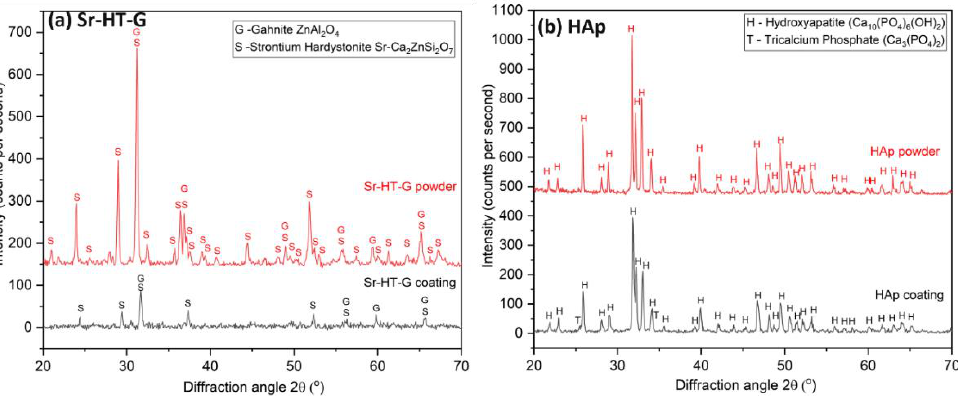
Figure 2. XRD results of Sr–HT–G powder and coating ( a ) and HAp powder and coating ( b ).